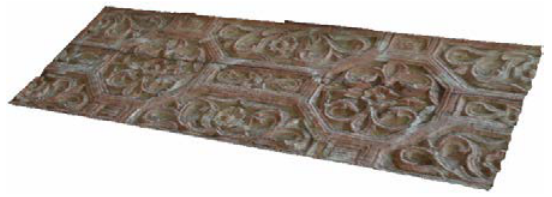
Fig.2 3D model of Roshan decorative